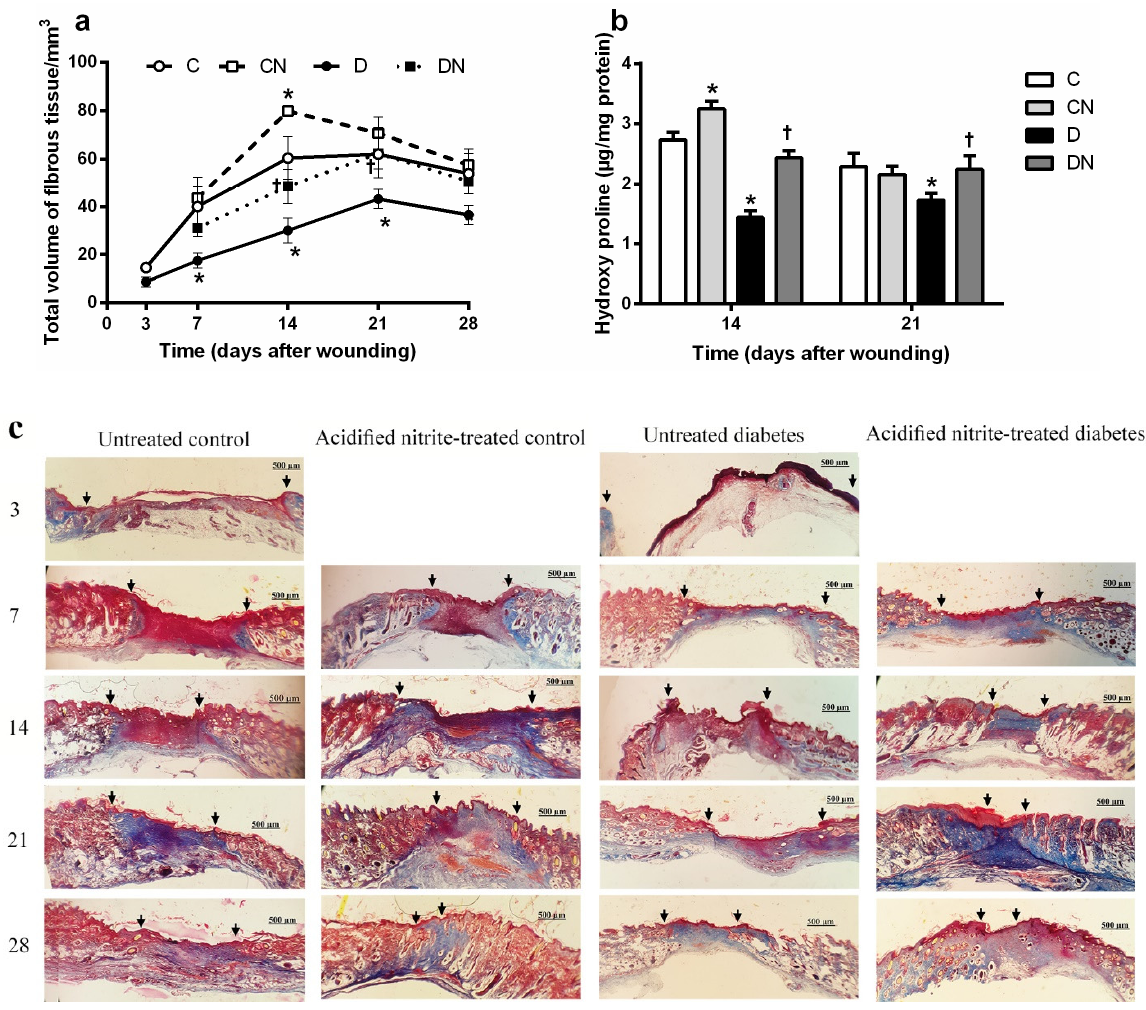
Figure 7. Effect of the topical acidified nitrite application on the total volume of fibrous tissue ( a ) and hydroxyproline content ( b ) ( n = 6/subgroup). Representative images of Masson’s trichrome-stained sections (specific for collagen) at days 3, 7, 14, 21, and 28 after wounding (1000× magnification and scale bar = 500 μ m) ( c ). Arrows, wound margin; C, untreated control; CN, acidified nitrite-treated control; D, untreated diabetes; and DN, acidified nitrite-treated diabetes. * p < 0.05 compared to untreated control rats, and † p < 0.05 compared to untreated diabetic rats. Values are the mean ± SEM.